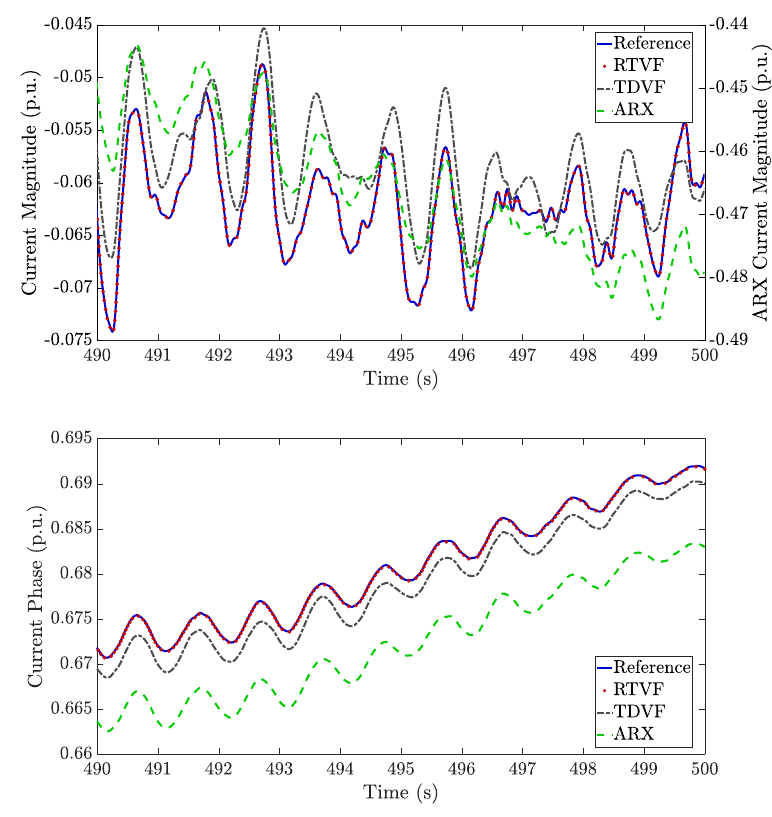
Figure 7. Wide area test case. Time domain validation of models derived by means of RTVF, ARX, and TDVF without inclusion of the initial conditions estimate. Top panel: Current magnitude deviation (note that the left y-axis applies to RTVF and TDVF, while right y-axis refers to ARX; the latter has difficulties in producing a sound approximation, especially at low frequencies). Bottom panel: Current phase